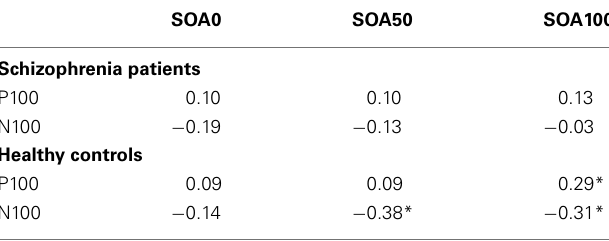
Table 3 | Correlations between backward masking performance (# targets correctly identified) and ERP